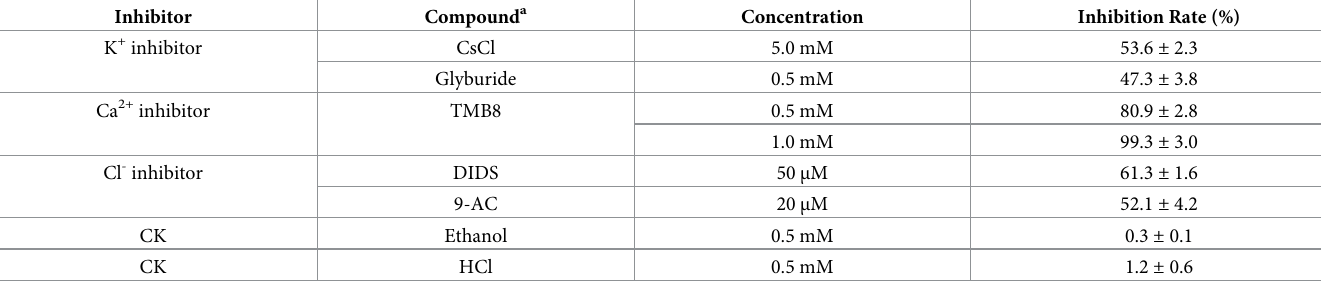
Table 2. Inhibition rate of ascospore discharge of PH-1 under various ionic inhibitors treatment.